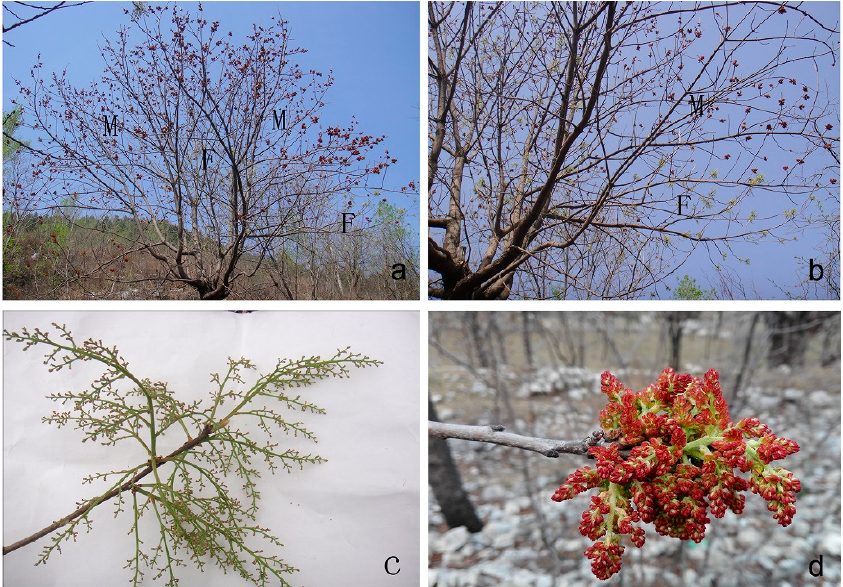
Figure 1. Characteristics of the selected monoecious Pistacia chinensis . Female and male branches of the selected tree ( a and b , respectively); female inflorescences ( c ); and male inflorescences ( d ).